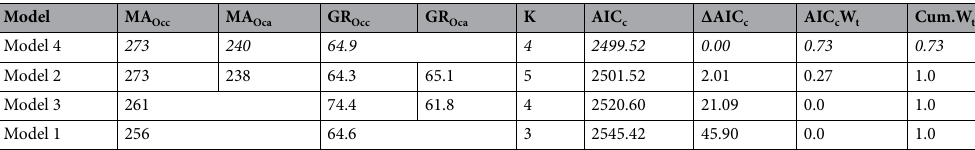
Table 1. Comparison of the four models considered depending on equality or difference of the parameters a , corresponding to maximum asymptotic (MA) and b , corresponding to growth rate (GR) of the age-LDW curves between both subespecies (Occ: Oryctolagus cuniculus cuniculus ; Oca: Oryctolagus cuniculus algirus ). Model with ΔAIC c < 2 is in italic. K the number of estimated parameters, AIC c the second-order Akaike information criterion, ΔAIC c the difference between AIC c and the lowest value of AIC c , AIC c W t the Akaike weight, Cum.W t the cumulative Akaike weight.